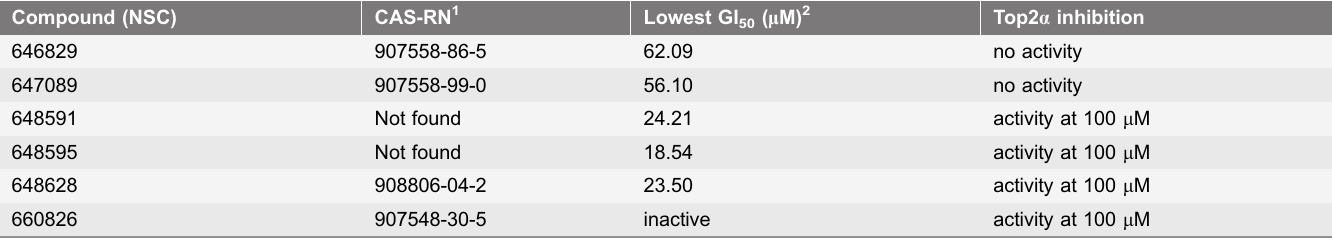
Table 2. Compounds selected from screening with etoposide pharmacophores – biological